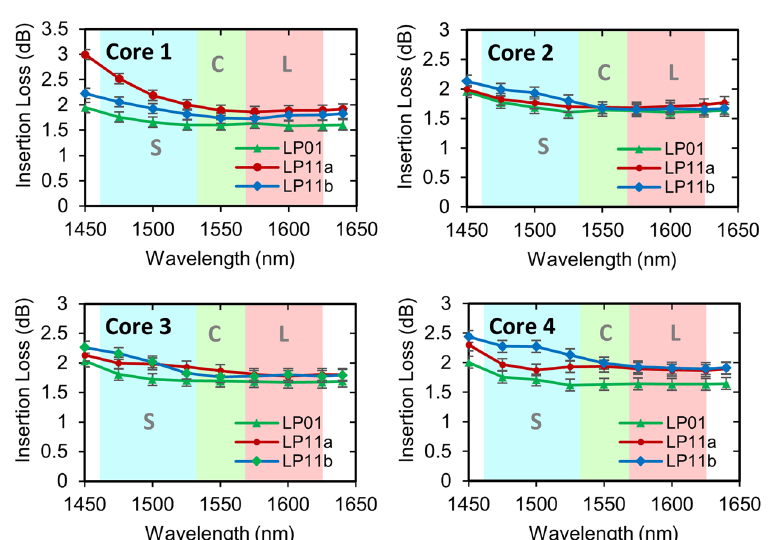
Figure 4. Chip insertion losses. Shown are the insertion losses for each of the four tapered mode couplers in the FM-MCF spatial multiplexer